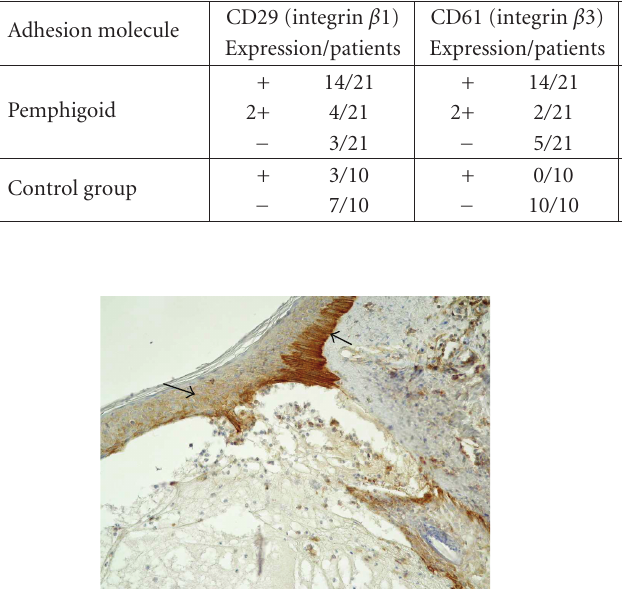
Figure 3: Skin lesions in BP, immunohistochemistry. Moderate ex- pression of β 3 integrin in basal keratinocytes and weak in the whole stroma (original magnification x100).